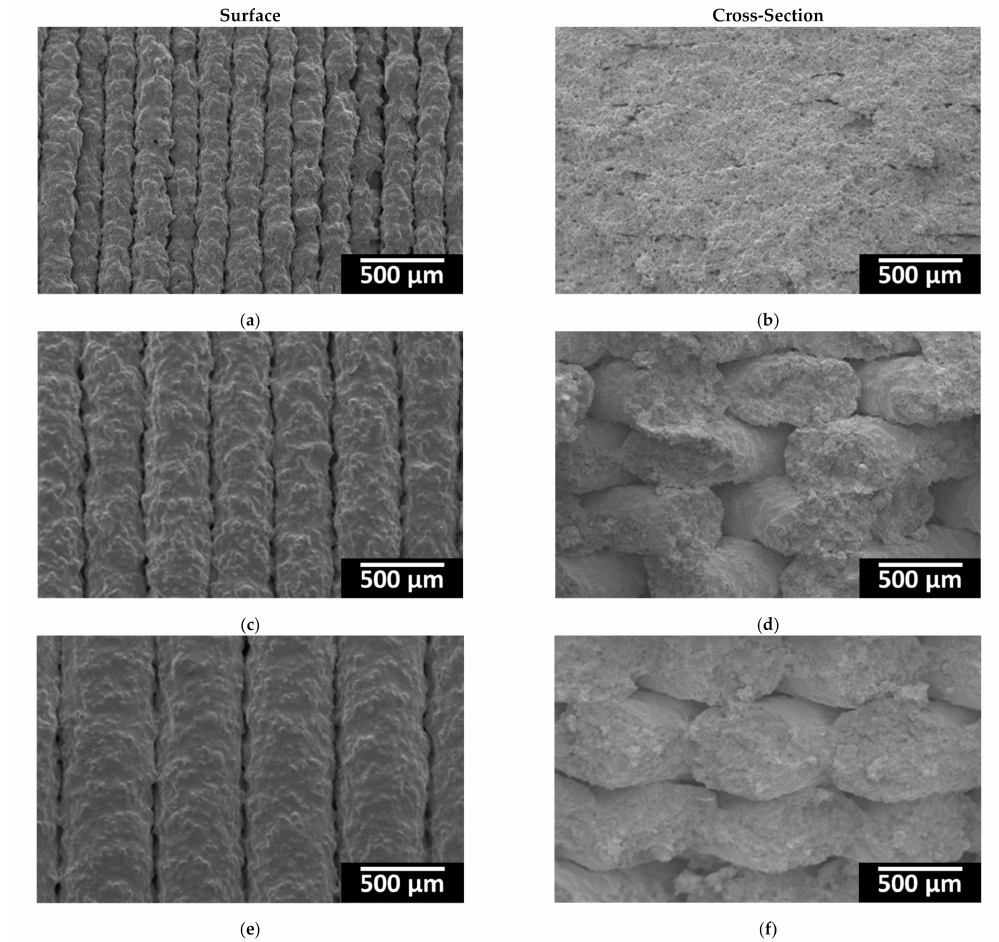
Figure 6. Surface and cross-sectional SEM images of printed samples at layer thickness of ( a , b ) 0.2 mm, ( c , d ) 0.4 mm and ( e , f ) 0.6